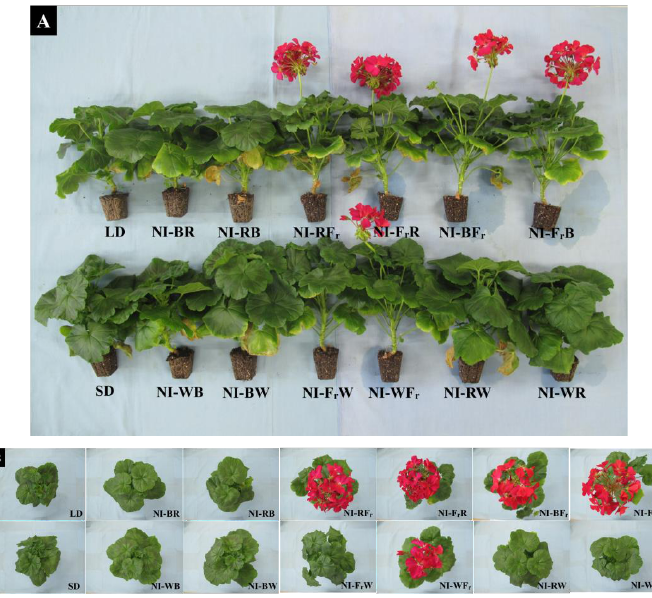
Figure 6. Effects of 10 μmol·m −2 ·s −1 PPFD night-interruption light (NIL) quality shifting on flowering of geranium ( Pelargonium × hortorum L.H. Bailey ‘Ringo 2000 Violet’) measured 40 days after treatment: side view ( A ) and top view ( B ). Please refer to Figure 1 for detailed NIL qualities.